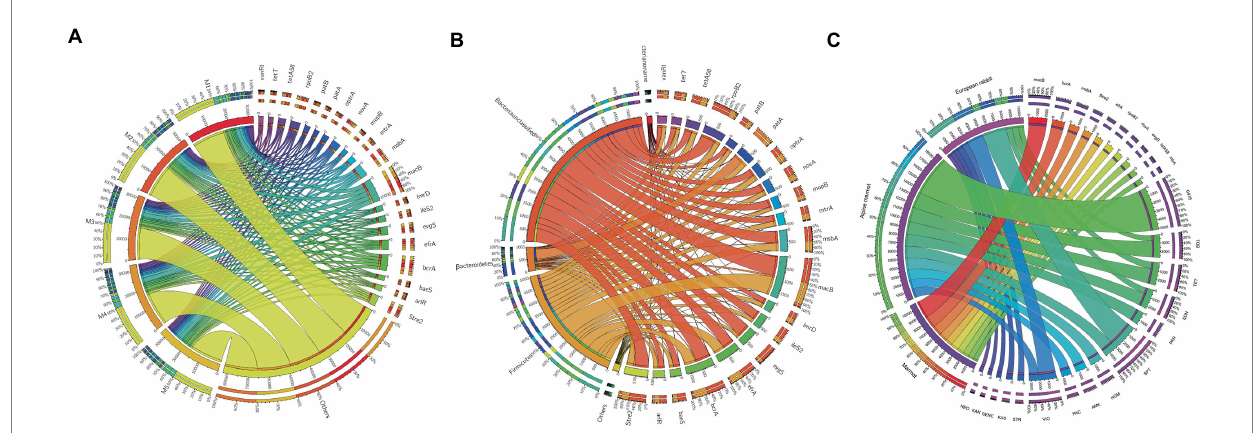
FIGURE 6 Antibiotic resistant genes (ARGs) types and their abundances. (A) Circos plot of relative abundances of ARGs. Right side shows antibiotic information and left side shows sample information. Outer circle indicates distribution of unique genes and inner circle shows different samples or